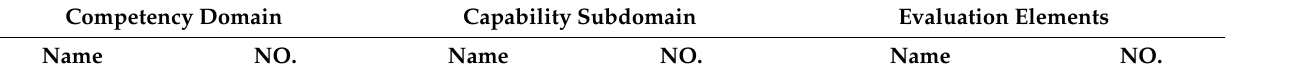
Table 2. Evaluation indicators of the intelligent manufacturing capability of chair industry